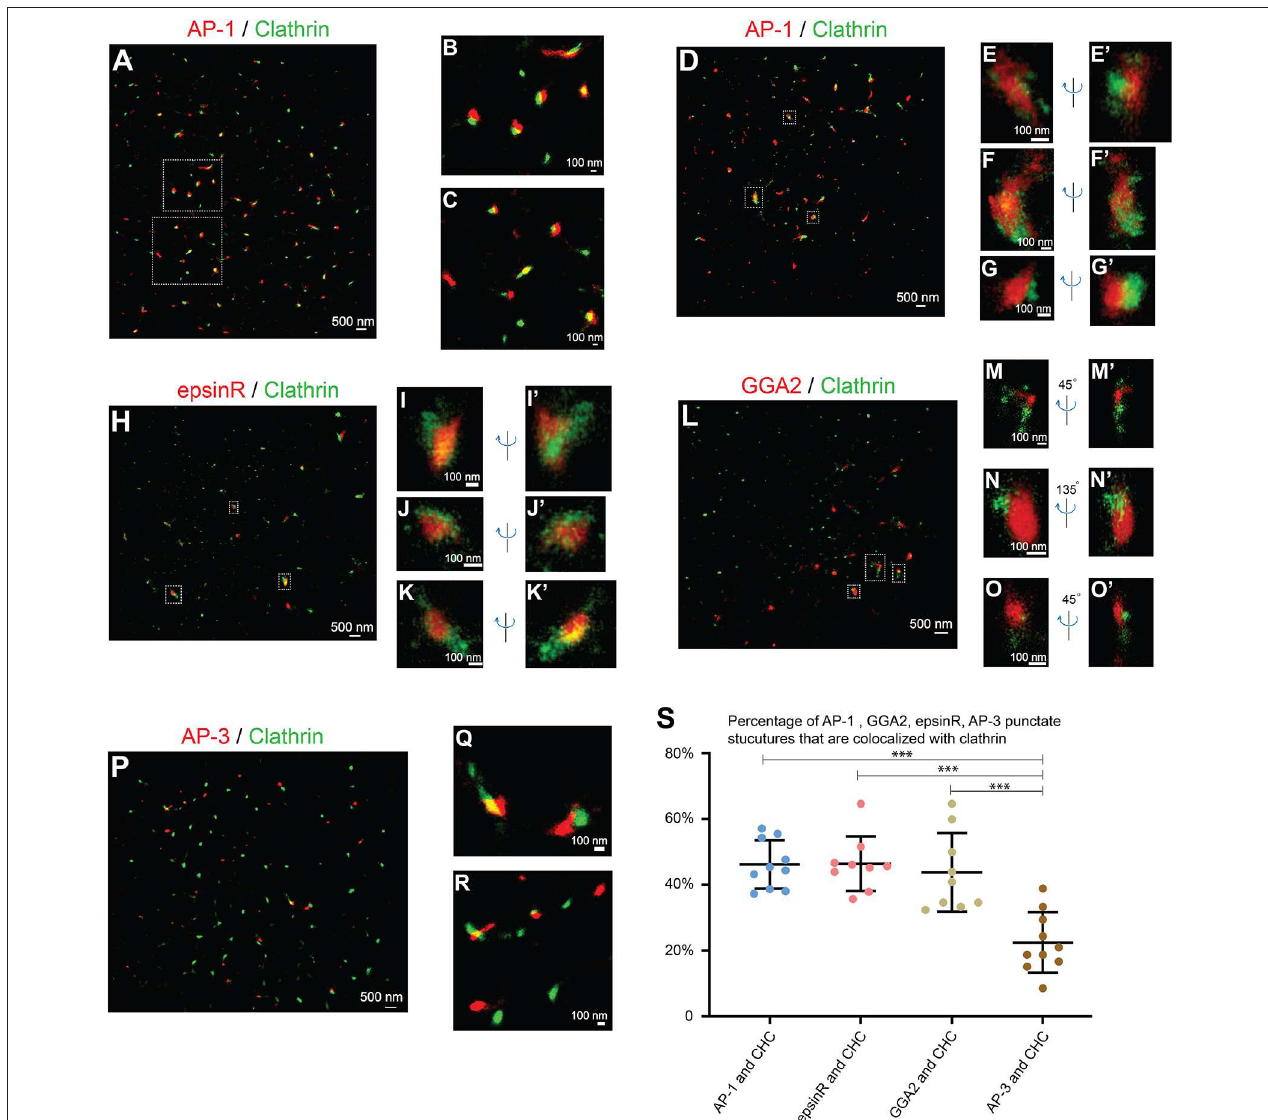
FIGURE 2 | Spatial relationship analysis between cargo adaptors and clathrin at the juxtanuclear area. (A–G’) COS7 cells were co-stained with antibodies against clathrin heavy chain and γ 1-adaptin. Localization patterns of AP-1 marked by γ 1-adaptin and clathrin marked by clathrin heavy chain in the same COS7 cell were analyzed by two-color STORM in 2-dimension (A–C) and 3-dimension (D–G’) . Magnified view of the indicated area in (A,D) were shown in (B,C) and (E–G’), respectively. (H–K’) . COS7 cells were transfected with epsinR-FLAG. Day 1 after transfection, cells were co-stained with antibodies against γ 1-adaptin and FLAG tag. 3- Dimensional localization patterns of epsinR-FLAG and clathrin heavy chain in the same COS7 cell were analyzed through two-color STORM. Magnified views of the indicated area in (H) were shown in (I–K’) . (L–O’) COS7 cells were co-stained with antibodies against clathrin heavy chain and GGA2. Localization patterns of GGA2 and clathrin heavy chain in the same COS7 cell were analyzed by two-color STORM in 3-dimension. Magnified views of the indicated area in (L) were shown in (M–O’) . (P–R) COS7 cells were co-stained with antibodies against clathrin heavy chain and AP3 δ 1. Localization patterns of AP-3 marked by AP3 δ 1 and clathrin heavy chain in the same COS7 cell were analyzed by two-color STORM in 2-dimension. Magnified views of the indicated area in panel P were shown in (Q,R) . (S) Quantification of fractions of AP-1, GGA2, AP-3, or epsinR punctae that were associated with clathrin based on super-resolution images acquired from three independent repetitions in each experimental group (mean ± SD, based on ≥ 9 super-resolution images). *** p < 0.001 by two-tailed Student’s t -test. Scale bar in each panel was indicated. The super-resolution images showed the localization patterns of the indicated protein in the whole juxtanuclear area where the majority of the cargo adaptors were localized. Each dot in the graphs represents data of the whole juxtanuclear Golgi area of each individual